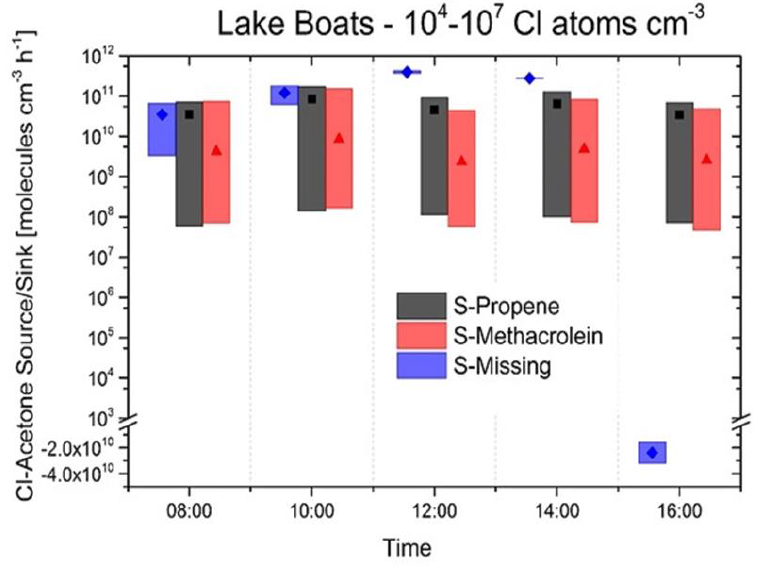
Figure 3. Amount of chloroacetone molecules derived from atmospheric reactions of measured propene (black) and methacrolein (red). Additional chloroacetone molecules, that are necessary for obtaining the measured mixing ratios (MR) in the chamber, are shown in blue and represent an unknown source.